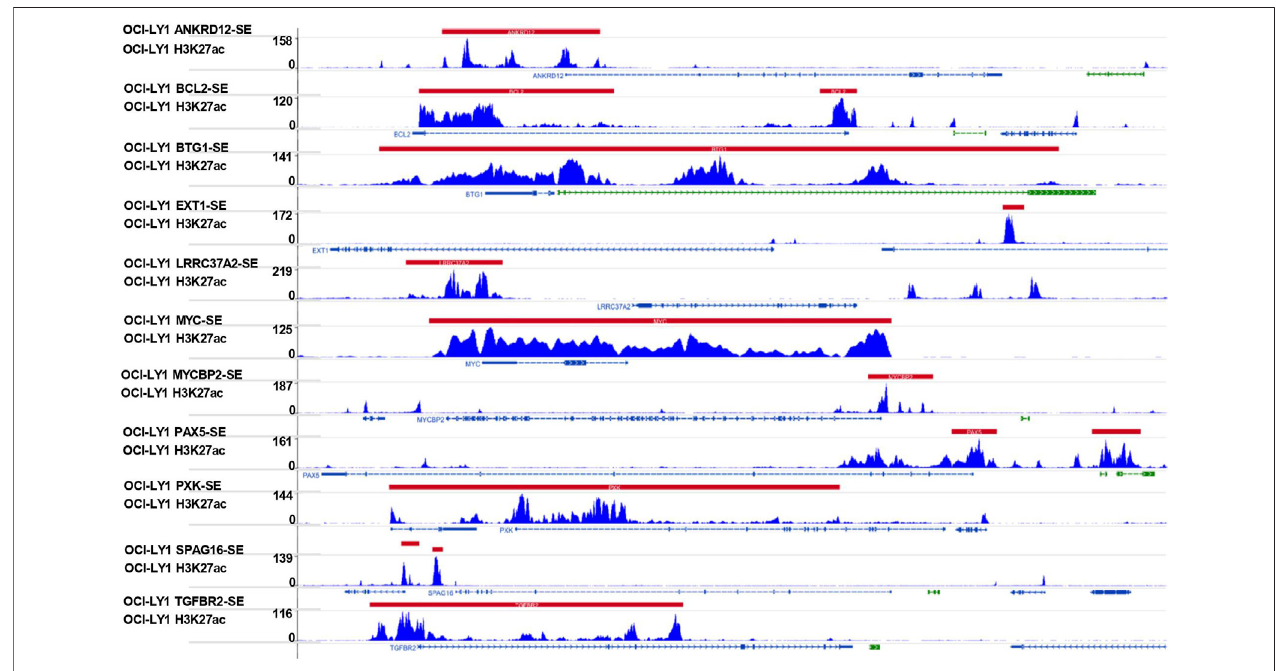
FIGURE 8 | Signal tracks for H3K27ac ChIP – seq pro fi les of the 11-SE-associated hub genes visualized using IGV. The regions of SE are shown in a red bar upon the signal tracks. ChIP – seq, chromatin immunoprecipitation – sequencing; SE, super-enhancer; IGV, Integrative Genomics Viewer.